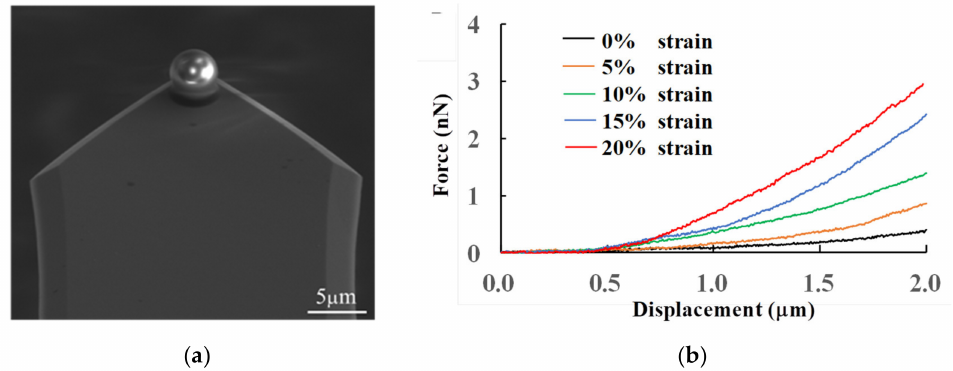
Figure 3. The force–displacement curves under the indentation depth of 1.5 µ m when using the spherical glass tip. ( a ) An SEM image of the spherical glass tip. ( b ) The representative force– displacement curves under different substrate